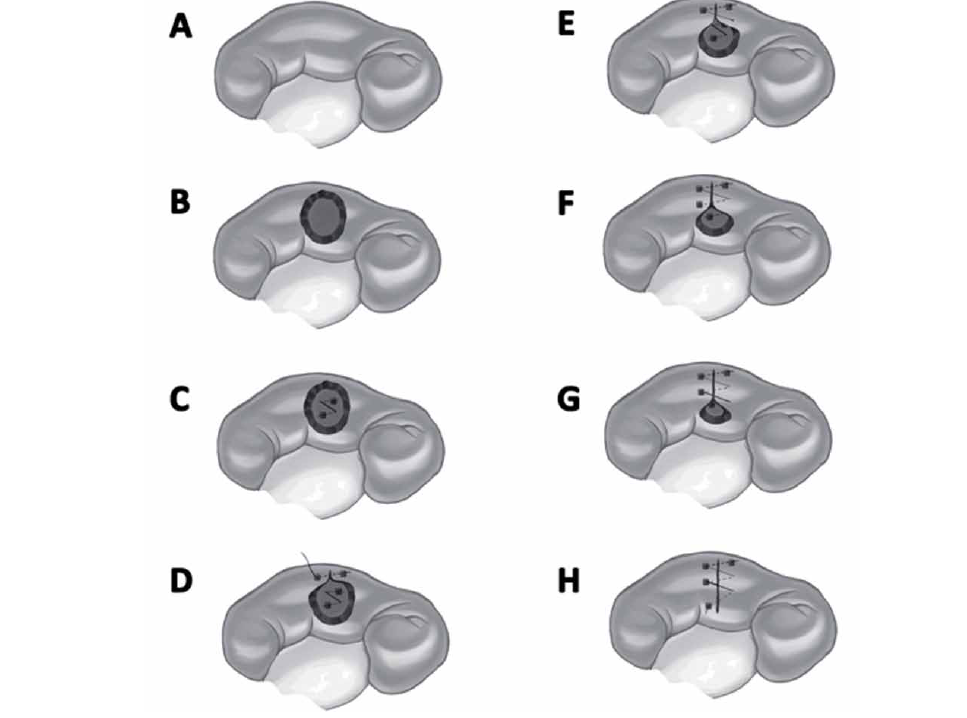
Figure 1 - sequential steps of renal defect closure during laparoscopic partial nephrectomy with a refined